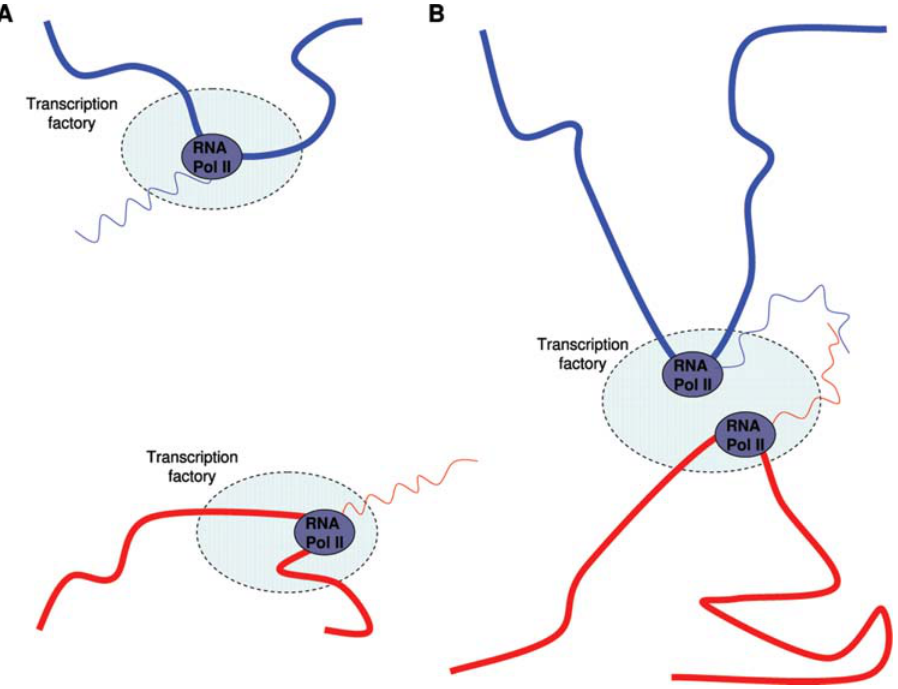
Figure 1. Chimeric mRNA revealing chromsome interaction. Schematic representation of regions of two chromosomes, represented by red and blue thick lines, with accompanying mRNA transcripts in corresponding colors, represented by wavy lines, transcription factories and RNA polymerases. When chromosomes are not in proximity, mRNAs are less likely to interact ( A ), whereas proximal chromosomes generate a chimeric mRNA, revealing interchromosomal interaction ( B ).